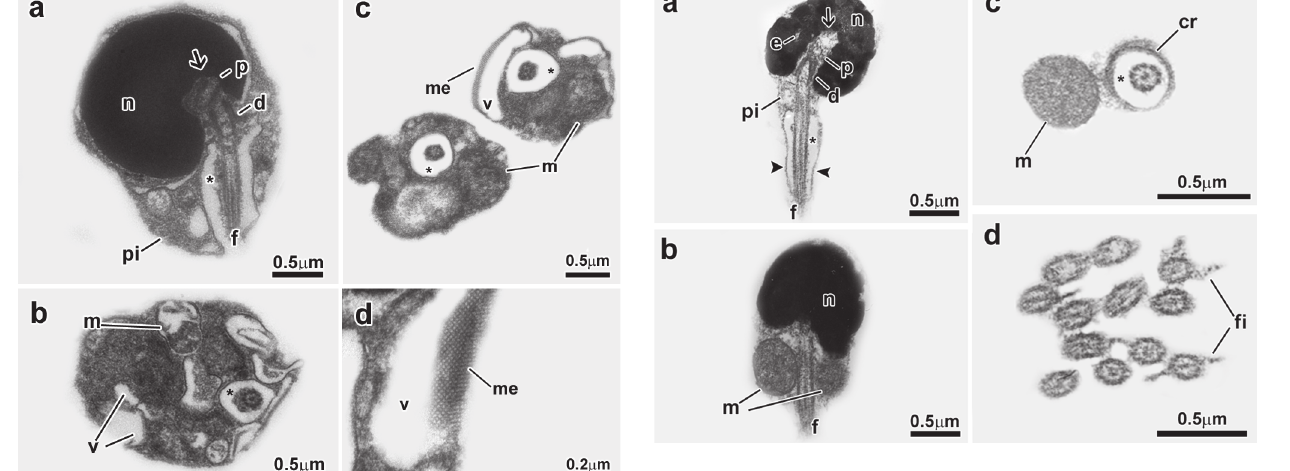
Fig. 8. Spermatozoon of Rhabdalestes rhodesiensis . a, d: longitudinal sections. b, c: transverse sections from top to posterior region. The nucleus (n) is spherical and lies strongly eccentric to the flagellum (f). The centriolar complex (p, d) and nuclear fossa (arrow) is strongly eccentric. The proximal centriole (p) is anterior and oblique relative to the distal centriole (d). The cytoplasmic canal is present (asterisk). The midpiece (pi) is strongly asymmetrical, and contains the spherical mitochondria (m) and vesicles (v). The membrane of the midpiece (me) has a striated aspect along its length (c, d). Legends: d: distal centriole, f: flagellum, m: mitochondria, me: membrane of the midpiece, n: nucleus, p: proximal centriole, v: vesicle, asterisk: cytoplasmic canal, arrow: nuclear fossa.